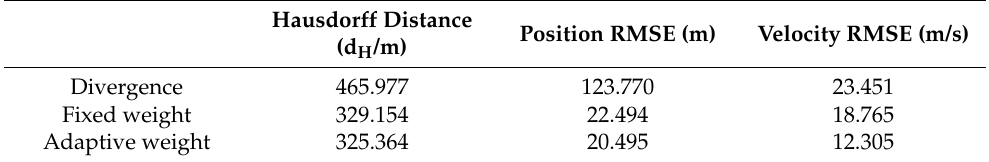
Table 10. Performance comparisons of the three algorithms in RS.